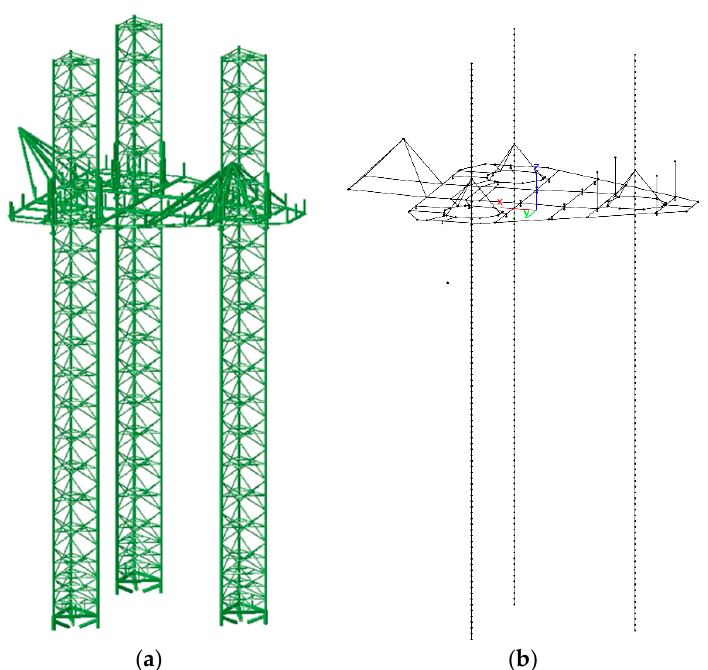
Figure 3. Full-order FE model of the jack-up ( a ) and the equivalent stick model ( b